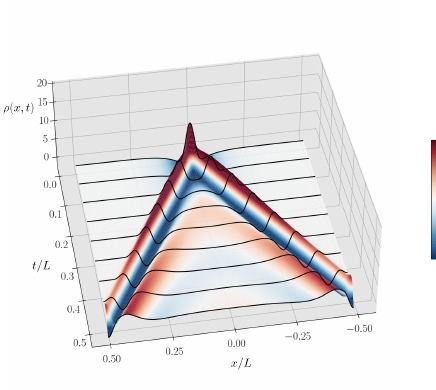
(b) Plots of the right-moving front in the co- moving frame for the same parameters as in (a) / 2.3, A β / m = 12, at various times. FF FF 1